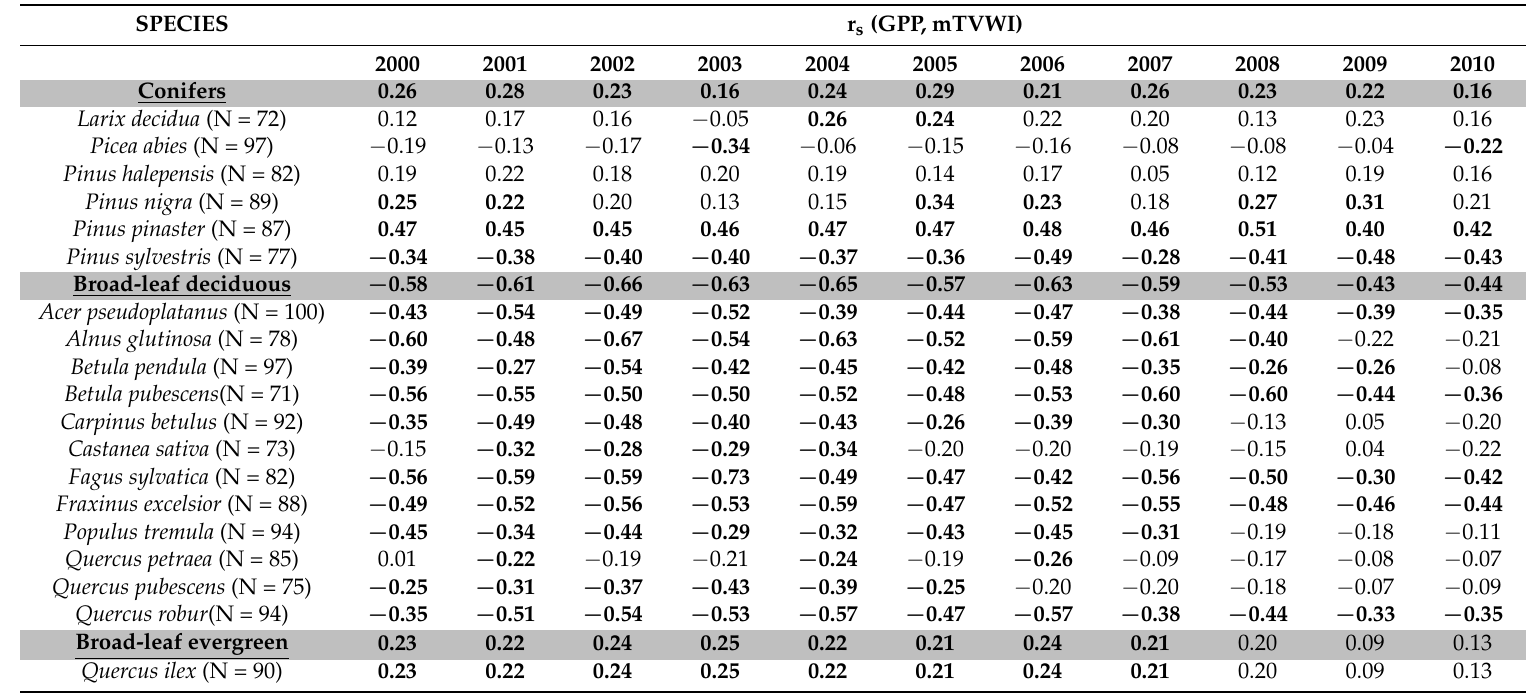
Table 2. Spearman rank-order correlation (rs) for the correlation between gross primary production (GPP) and the modified temperature vegetation wetness index (mTVWI). Bold indicates significance at p <